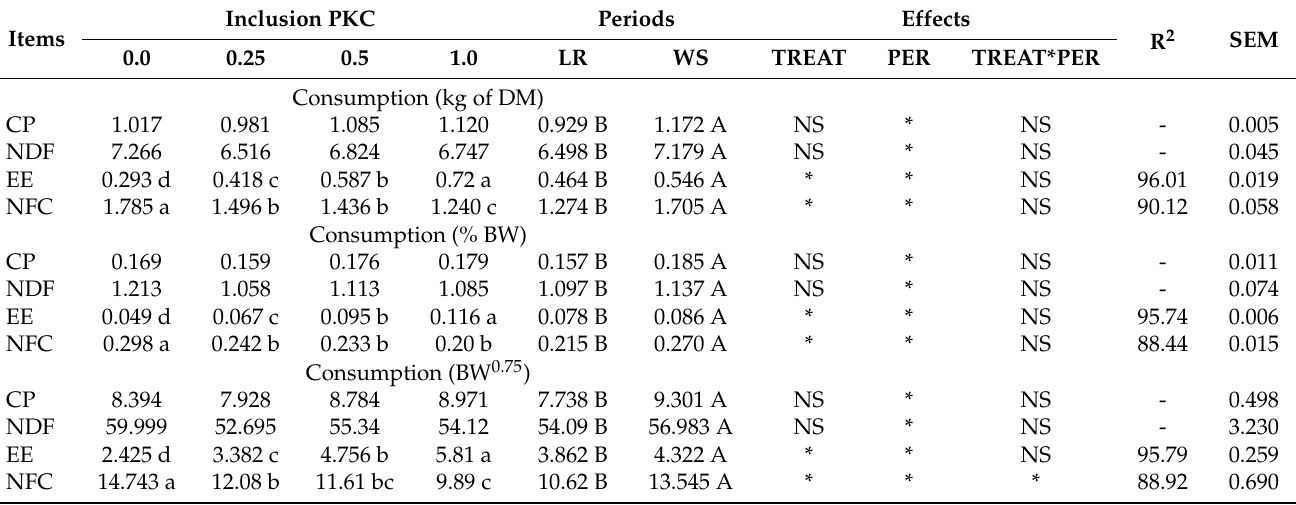
Table 4. Chemical analysis of consumption as a function of increasing levels of palm kernel cake by buffaloes in two seasons in the eastern Amazon.